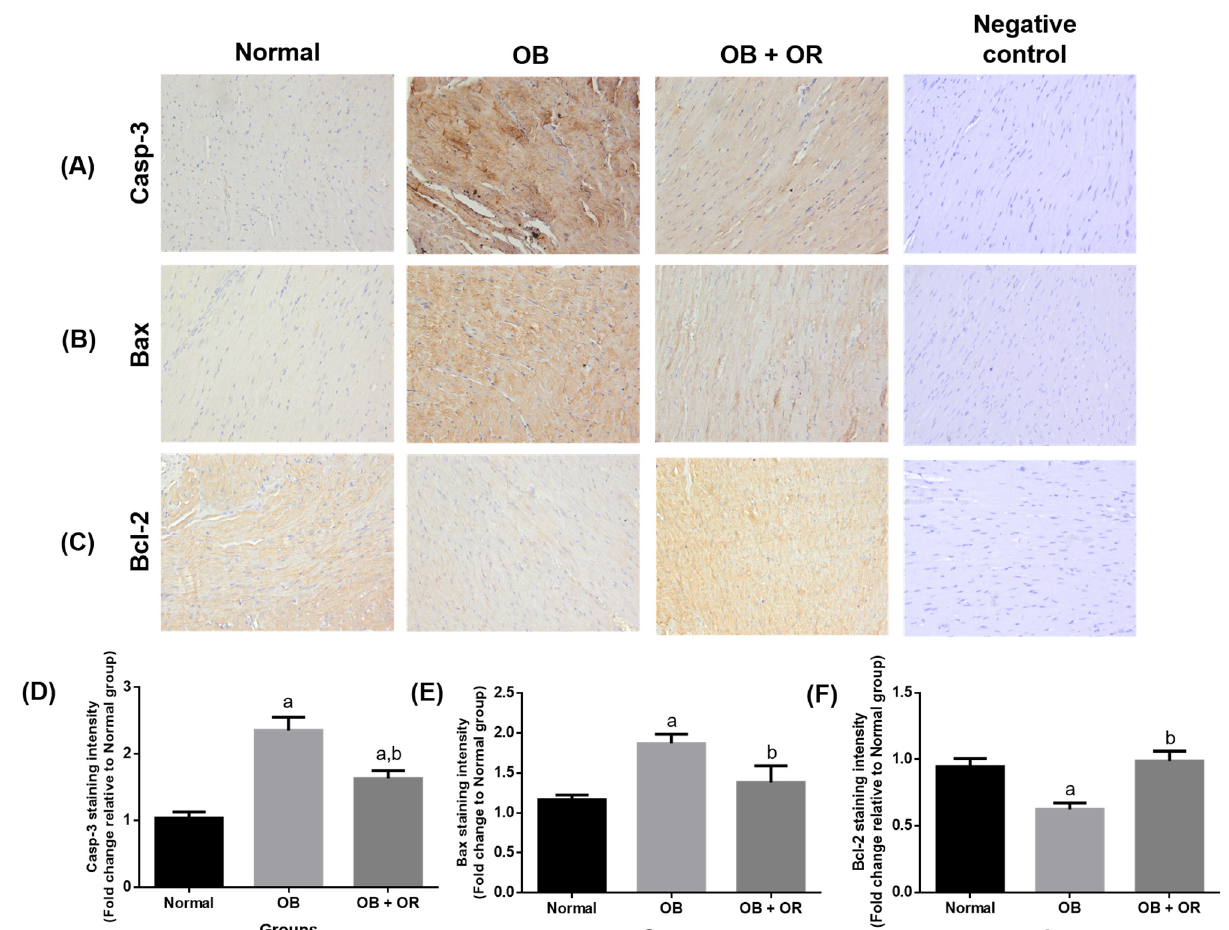
Figure 5. Effects of orlistat on immunoexpression of ( A ) Casp-3, ( B ) Bax, and ( C ) Bcl-2 in cardiac section of rats in Normal, OB (obese control), OB + OR (obese and orlistat 10 mg/kg/day) and negative control groups (magnification = × 400, scale bar = 50 µ m). For each target protein, phosphate buffered saline was substituted for the primary antibody in the negative control experiment. Staining intensities are shown in ( D – F ) and presented as mean and SEM values for respective proteins; n = 6 rats per group. a p < 0.05 compared with Normal group, b p < 0.05 compared with OB group. Data were analyzed by One-way ANOVA followed by Tukey’s post-hoc test. Bax; Bcl-2 associated X protein, Bcl-2; β -cell lymphoma-2, Casp;